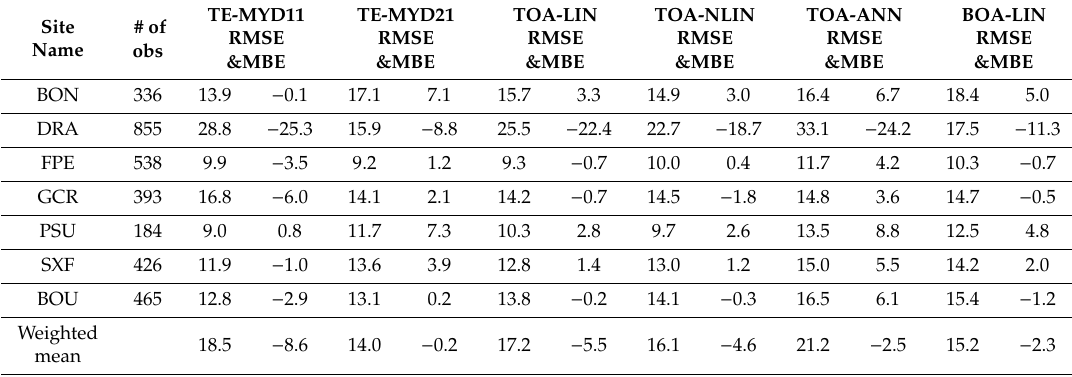
Table 8. Summary of validation results for six methods over 7 SURFRAD sites (W / m 2